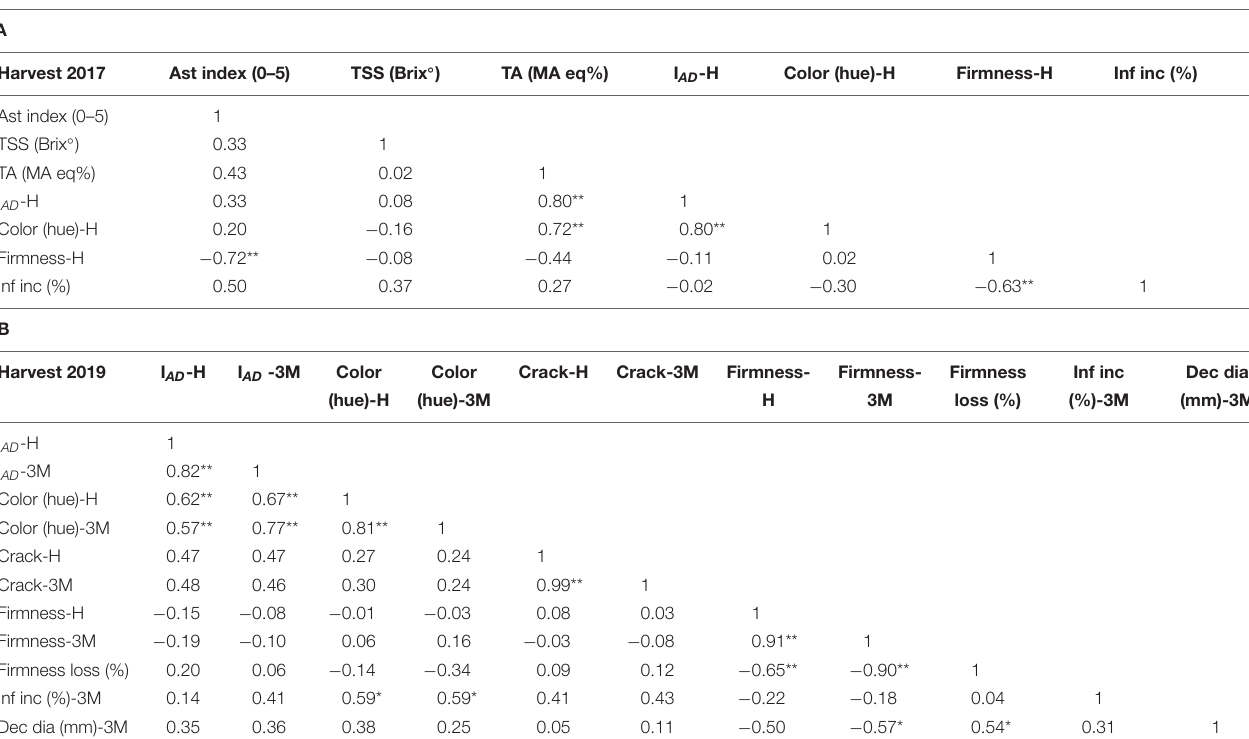
TABLE 2 | Pearson correlation coefficients (R) matrix for fruit quality traits among the different harvested persimmon cultivars. (A) Harvest 2017. (B) Harvest